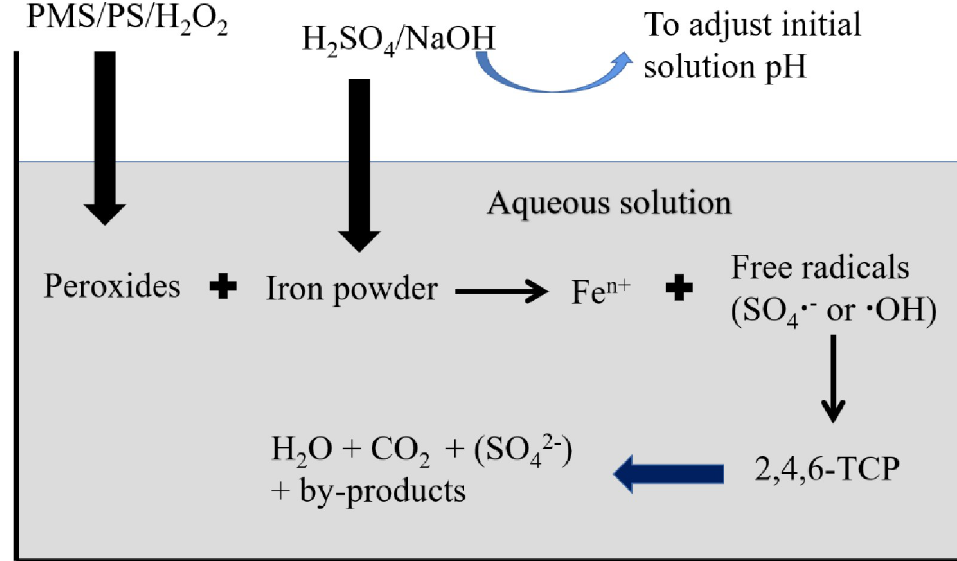
Fig 1. The scheme of peroxides activation by